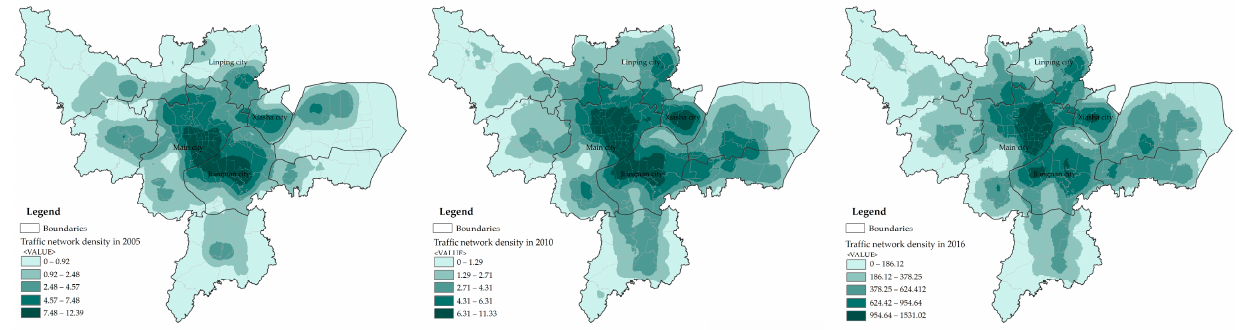
Figure 3. Traffic network density in Hangzhou in different years.